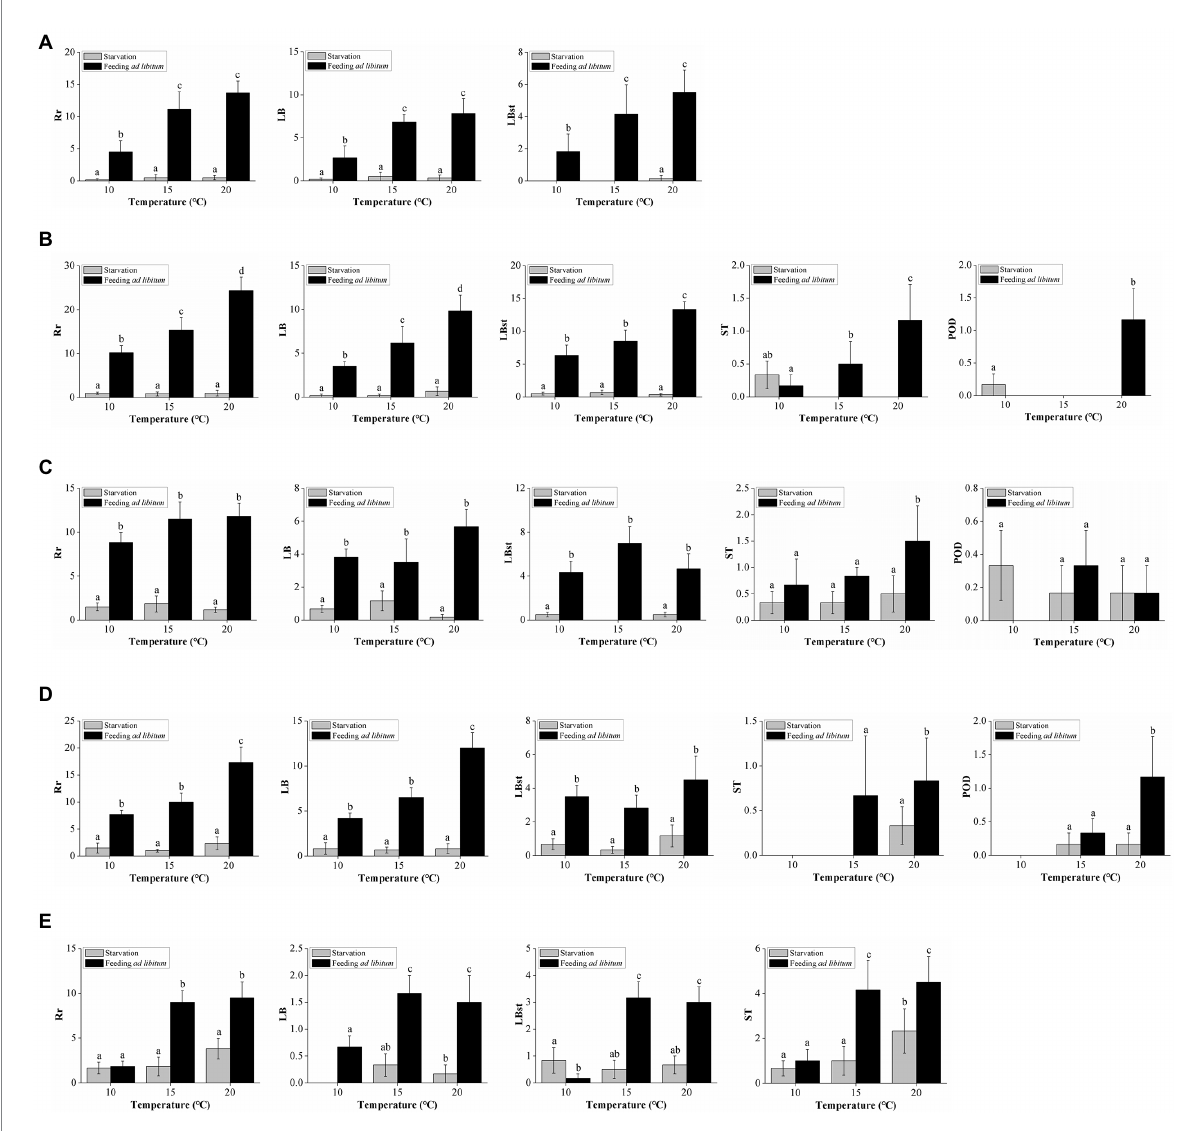
FIGURE 3 Effects of temperature and food supply on overall and specific reproduction rates of (A) Aurelia coerulea CHI , (B) A. coerulea USA , (C) A. coerulea SPA , (D) A. solida SLV , (E) A. solida ISR . Rr: number of new polyps produced during the experiment; LB: number of polyps produced by typical lateral budding; LBst: number of polyps produced by lateral budding by means of stolons; ST: number of polyps produced from parts of stolons/stalks; POD: number of podocysts produced during the experiment. Data are mean numbers of each variable ± standard deviation. Different letters represent significant differences at α =